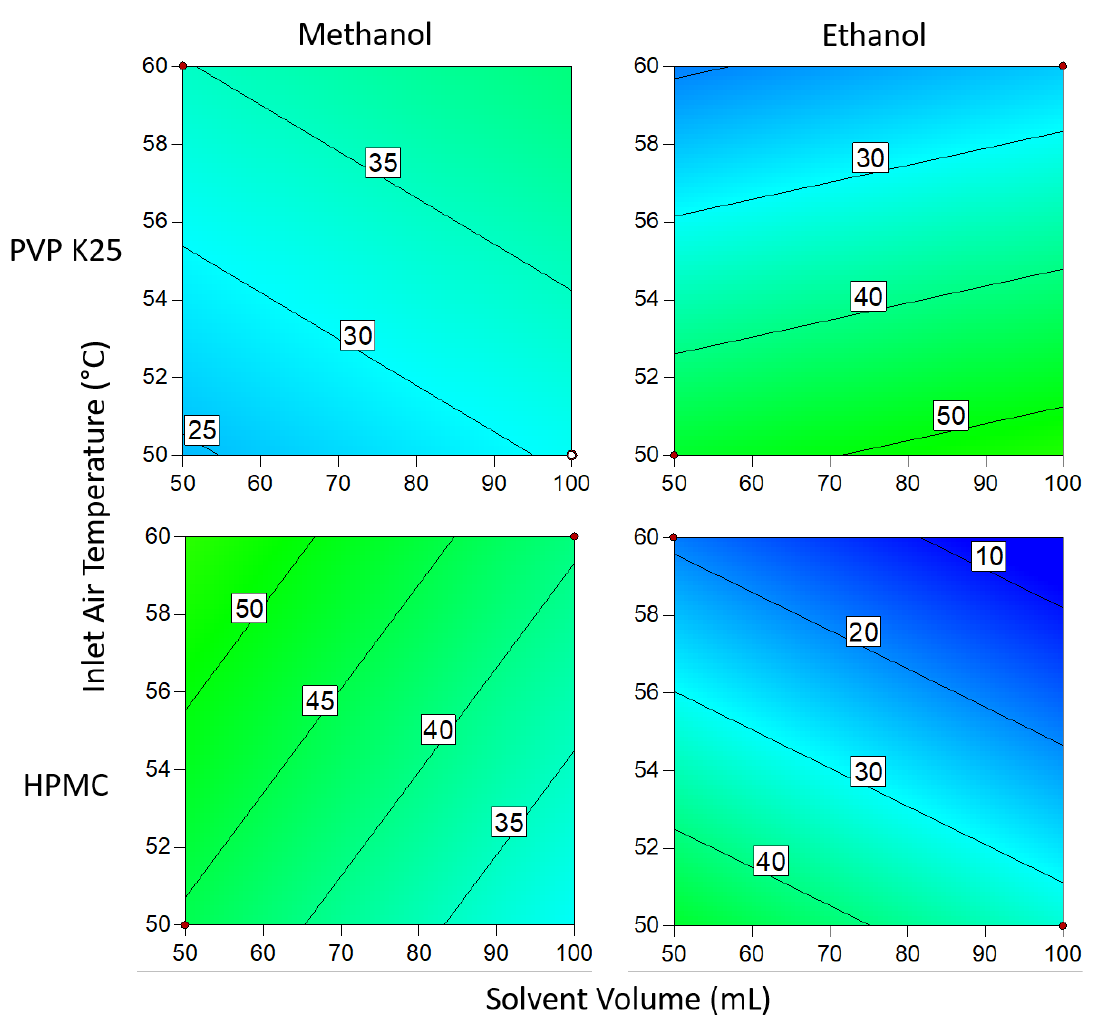
Figure 10. Degree of crystallinity when 3 g of binder is used. Numbers and tie lines correspond to points of equal DoC